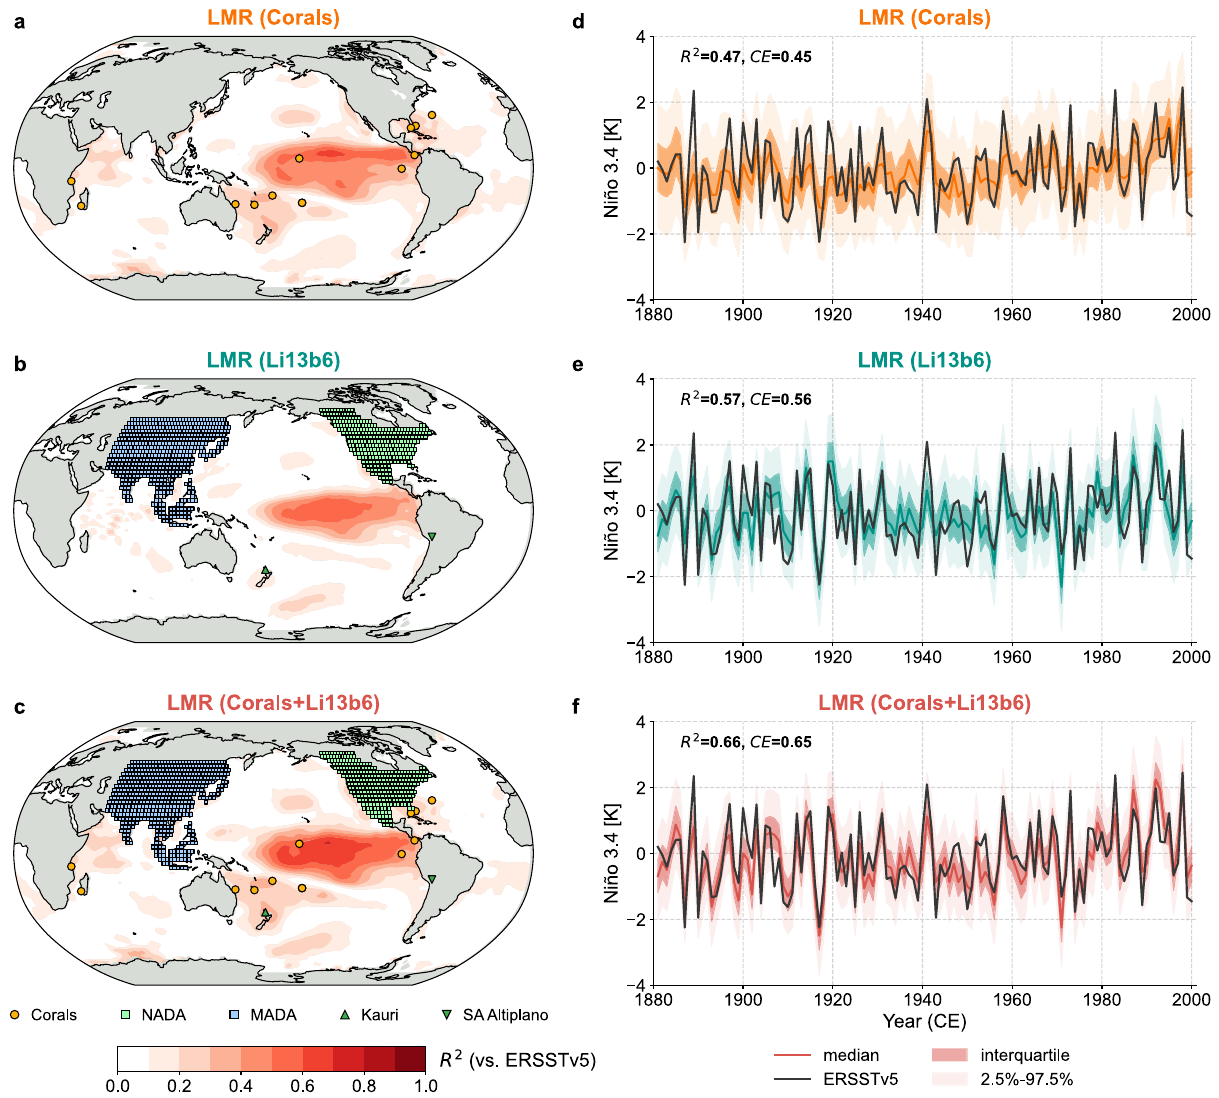
Fig. 1 Validation of the last millennium reanalysis (LMR) 31,32 sea surface temperature reconstructions over the instrumental period (1881 – 2000 CE). The labels LMR (Corals), LMR (Li13b6), and LMR (Corals + Li13b6) denote the reconstructions assimilating corals reaching back before 1750 CE from the Ocean2k compilation 30 , updated with the latest Palmyra data 28 , the six best predictors from Li et al. 12 (denoted as Li13b6), and both data sources, respectively. a – c Spatial veri fi cation of the median fi eld of the reconstructed boreal winter (December – February, DJF) surface temperature. Validation is performed against the Extended Reconstructed Sea Surface Temperature, Version 5 (ERSSTv5) 40 . The orange dots denote the location of the corals, the mint and blue squares denote the location of the North American Drought Atlas (NADA) (Version 2a) 41 and Monsoon Asia Drought Atlas (MADA) 42 sites, the green upward triangle denotes the location of the Kauri tree-ring composite 43 , and the green downward triangle denotes the location of the South America Altiplano (SA Altiplano) tree-ring composite 44 . d – f Temporal veri fi cation of the median of the LMR reconstructed DJF Niño 3.4 series (colored curves) against the ERSSTv5 derived Niño 3.4 (black solid curve). For each reconstruction, dark shading denotes the interquartile range, and light shading denotes the central 95% region, from 2.5% to 97.5%. R 2 = coef fi cient of determination, CE = coef fi cient of ef fi ciency 70